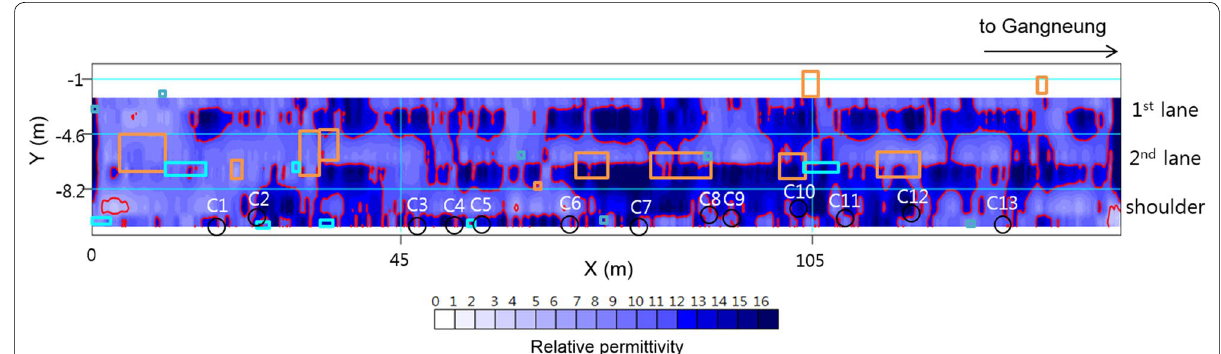
Fig. 10 Condition map based on the relative permittivity of concrete measured by air‑coupled GPR system on the pilot bridge: red lines indicates the relative permittivity values of 6 and 12. For a comparison, various types of damages on the surface in Fig. 5 are shown in the figure ( (cid:826) : core, ― : surface‑breaking cracks, □ : efflorescence, □ : patching and □ :